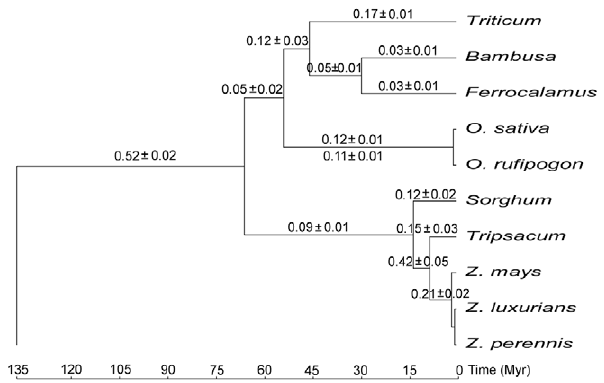
Figure 4. Absolute substitution rates during the evolutionary history of grasses. Values above each branch indicate absolute substitution rate (R) in substitutions per site per billion years (SSB) for that branch. Among them, 0.12 6 0.01 and 0.11 6 0.01 above and below the branch to Oryza are the mean values along the lineage from the common ancestor of Oryza / Triticum to O. sativa and O. rufipogon , respectively, while 0.21 6 0.02 above the branch to Zea is the average value of R along the lineage from the common ancestor of Zea / Tripsacum to three Zea species.